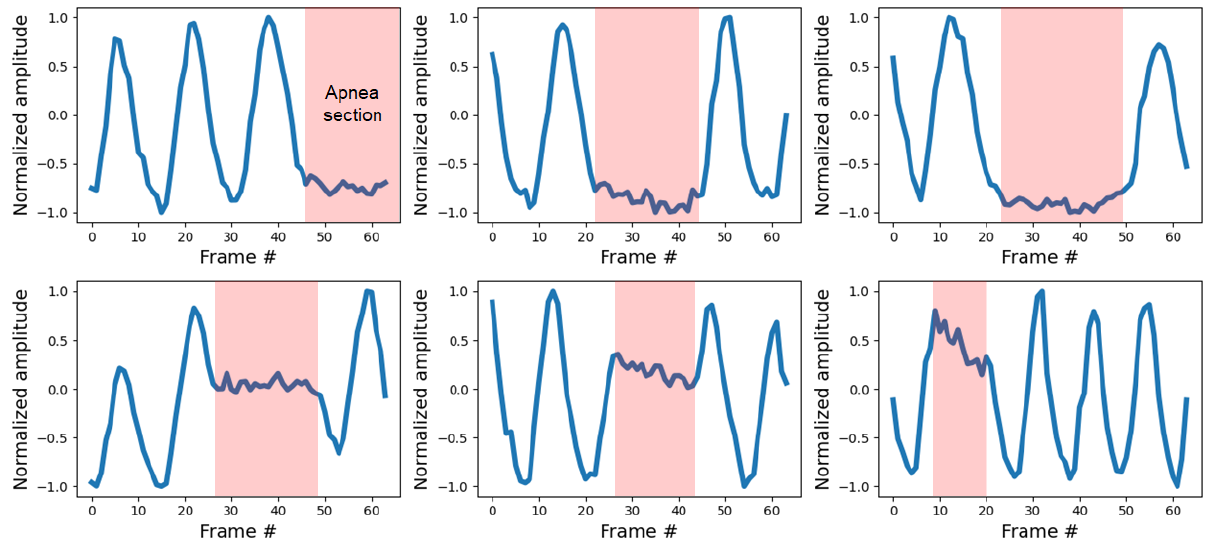
Figure 12. Measurement results of the proposed method for the case where the apnea section is included during breathing.